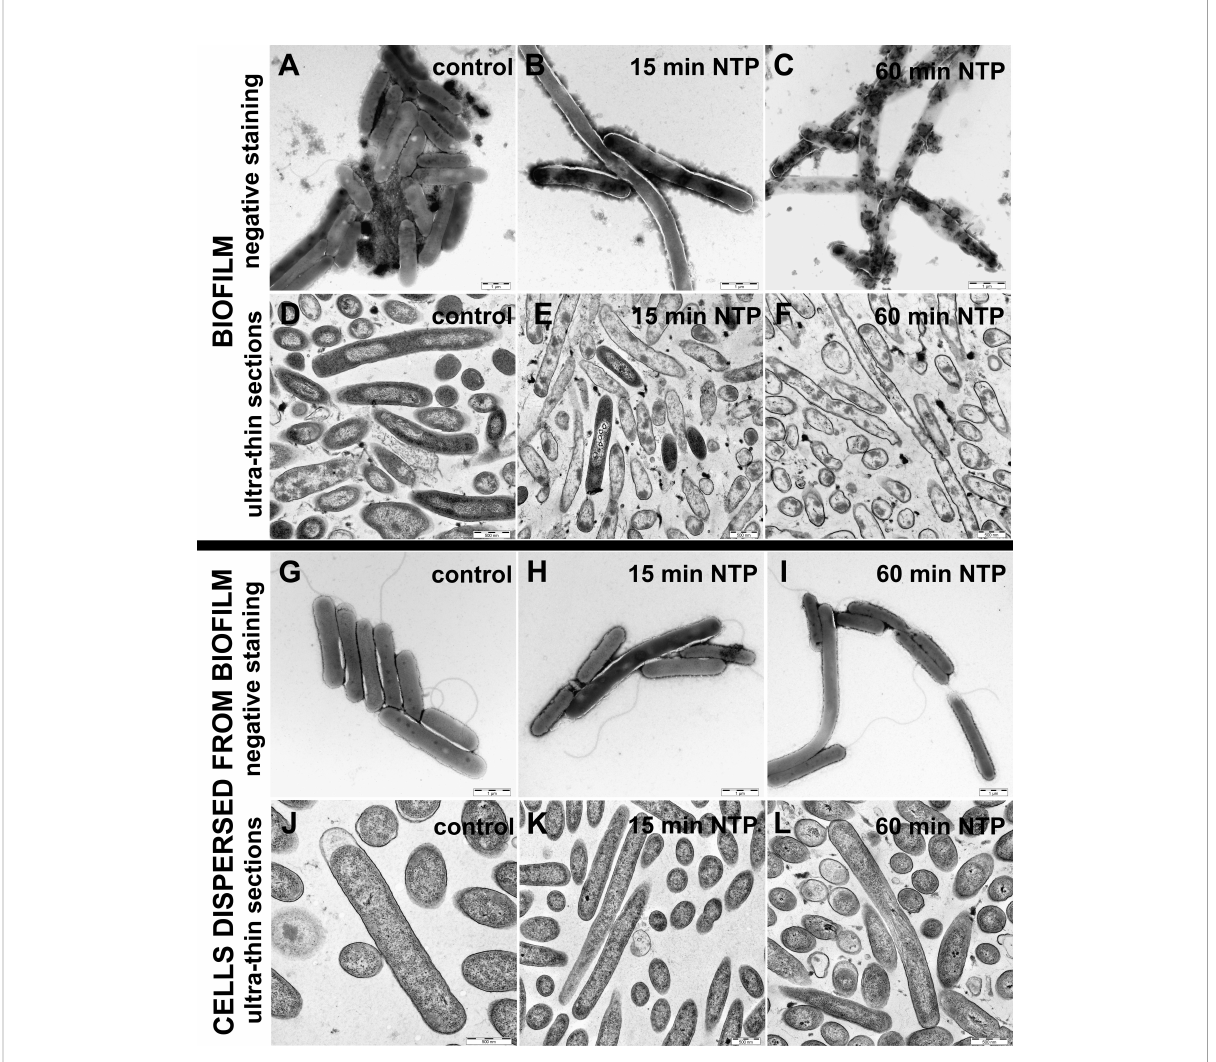
FIGURE 4 Effect of NTP on cell morphology of bio fi lm cells and cells dispersed from bio fi lm of Pseudomonas aeruginosa DBM 3181 visualized by transmission electron microscopy. (A) – bio fi lm untreated cells (negative staining), (B) – bio fi lm cells treated with 15 min of NTP (negative staining), (C) – bio fi lm cells treated with 60 min of NTP (negative staining), (D) – bio fi lm untreated cells (ultra-thin sections), (E) – bio fi lm cells treated with 15 min of NTP (ultra-thin sections), (F) – bio fi lm cells treated with 60 min of NTP (ultra-thin sections), (G) - cells dispersed from untreated bio fi lm (negative staining), (H) - cells dispersed from bio fi lm treated with 15 min of NTP (negative staining), (I) - cells dispersed from bio fi lm treated with 60 min of NTP (negative staining), (J) - cells dispersed from untreated bio fi lm (ultra-thin sections), (K) - cells dispersed from bio fi lm treated with 15 min of NTP (ultra-thin sections), (L) - cells dispersed from bio fi lm treated with 60 min of NTP (ultra-thin sections). Scale bars for negative staining and ultra-thin sections are 1 µm and 500 nm,